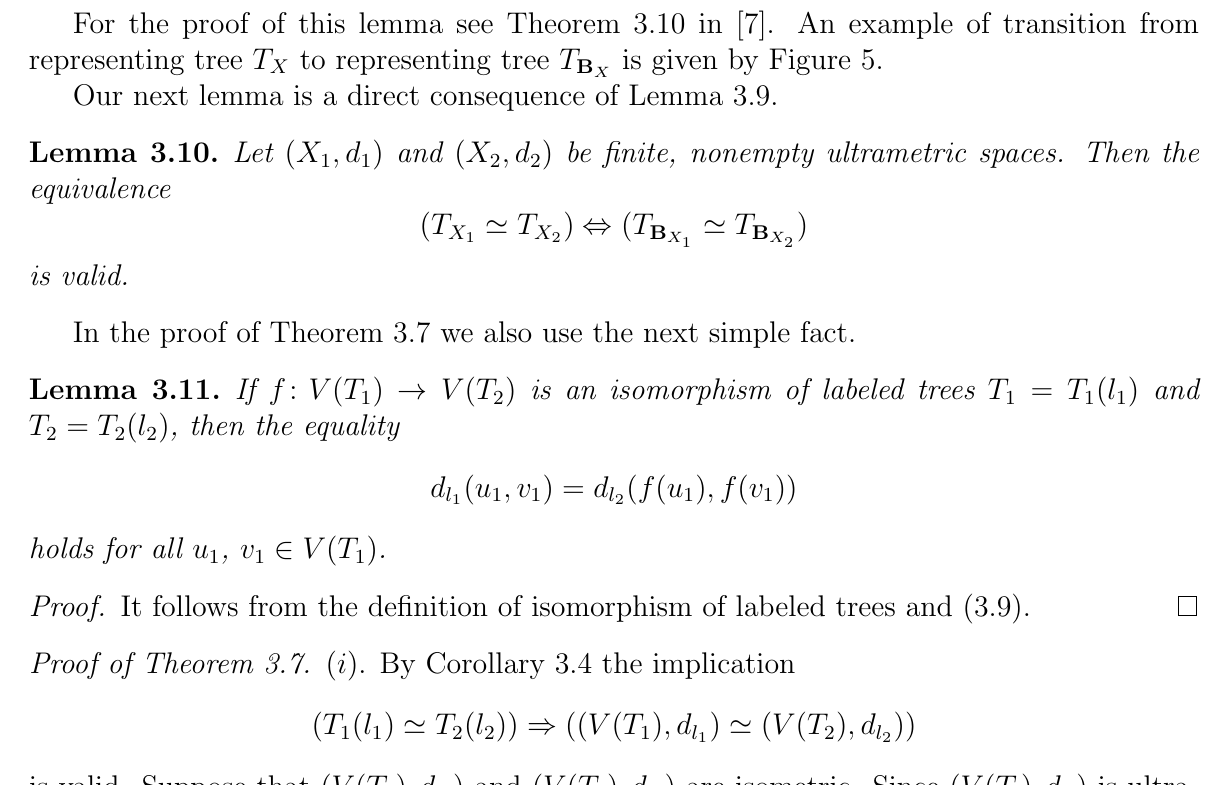
of finite ultrametric space ( X, d ) (from Example 2.1) and X of ( B , d B X X H